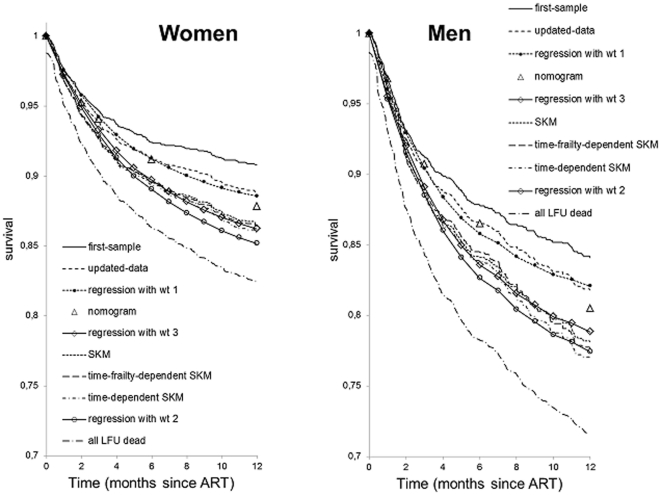
Patient survival in men and women.The upper and lower packs of line identifiers correspond respectively to the visibly grouped graphs or methods. SKM = stratified Kaplan-Meier method, wt = weight.